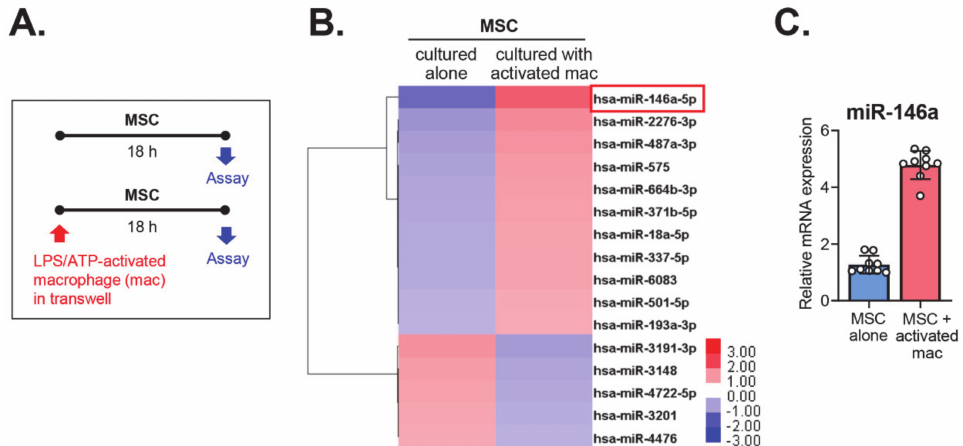
Figure 1. The miRNA changes in mesenchymal stem / stromal cells (MSCs) after co-culture with activated macrophages. ( A ). Experimental scheme. MSCs were cultured alone or co-cultured with macrophages activated by lipopolysaccharide (LPS) and adenosine triphosphate (ATP). Eighteen hours later, the MSCs were evaluated by miRNA microarrays and real-time reverse transcription polymerase chain reaction (RT-PCR). ( B ). Heat-map of microarray assays for miRNAs that were up- or downregulated > three-fold in MSCs co-cultured with activated macrophages, as compared to MSCs cultured alone. ( C ). The level of miR-146a in MSCs cultured with activated macrophages relative to MSCs cultured alone, as determined by real-time